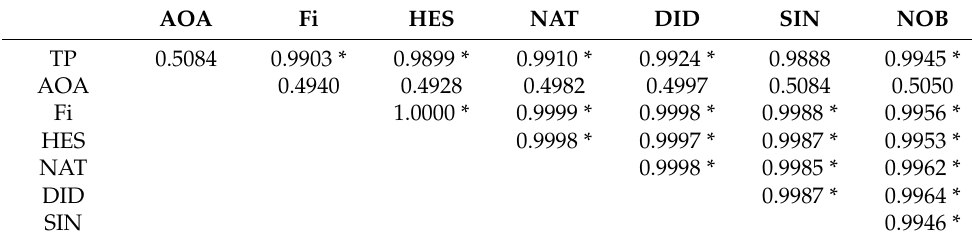
Table 2. Pearson correlation coefficients between total phenols (TP), hesperidin (HES), narirutin (NAT), didymin (DID), nobiletin (NOB), sinensetin (SIN), the sum of identified flavonoids (Fi), and antioxidant activity (AOA) analyzed in the four phenolic extracts of powdered orange by-product. AOA Fi HES NAT DID SIN NOB TP 0.5084 0.9903 * 0.9899 * 0.9910 * 0.9924 * 0.9888 0.9945 * AOA 0.4940 0.4928 0.4982 0.4997 0.5084 0.5050 Fi 1.0000 * 0.9999 * 0.9998 * NAT 0.9998 * 0.9985 * 0.9962 * DID 0.9987 * 0.9964 * SIN 0.9946